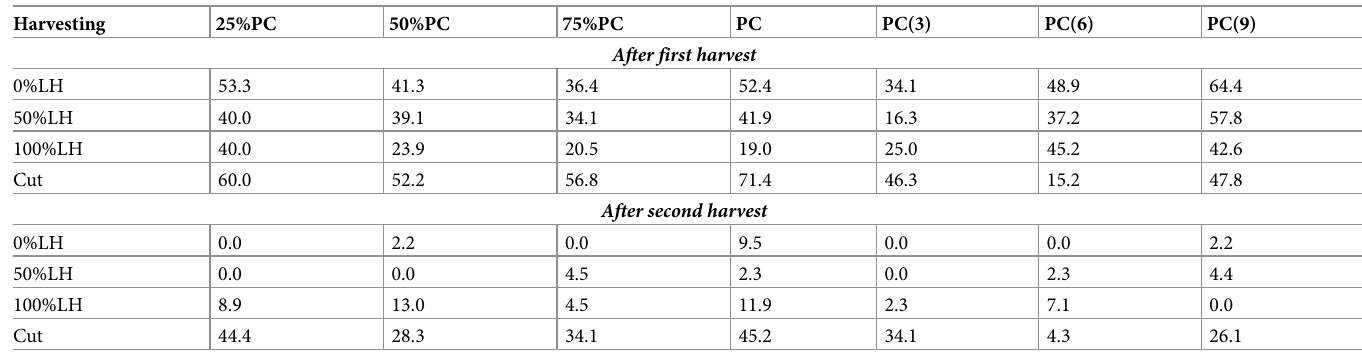
PC = Pot capacity; (3), (6), (9) = every three, six and nine days, respectively; LH = Leaves harvested; Cut = all the leaves harvested with the supporting part of stem. After the second harvest (in Amaranthus sp .), a similar trend to the period after the first har- vest was observed for plant survival in the control treatment and the treatments with reduced daily amount and least reduced frequency of watering PC(3); the treatment Cut displayed the highest rate (Table 8). However, contrary to the previous period, the rate increased with harvest- ing, although there were some exceptions with the treatment 50%LH or 100%LH depending on the case. For the other parameters, no clear trends were observed. However, in terms of plant height and leaf production (Fig 2B and 2C), the treatment 100%LH displayed the highest mean values with the greatest reduction in the amount of watering (25% and 50%PC), while the treat- ment 50%LH obtained the highest mean values with the least reduced amount of water (75% PC). The cut plants had the lowest height while plants with 100%LH had the highest number of leaves per plant in the control water treatment. The plants with 100%LH and 50%LH had the highest mean height respectively with medium and high reduction in the frequency of watering.